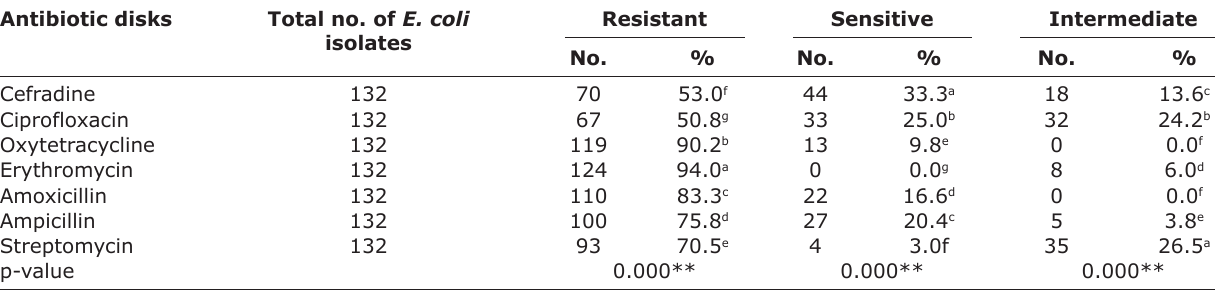
Table-8: Results of the antibiotic sensitivity test of E. coli isolated from poultry samples. Antibiotic disks